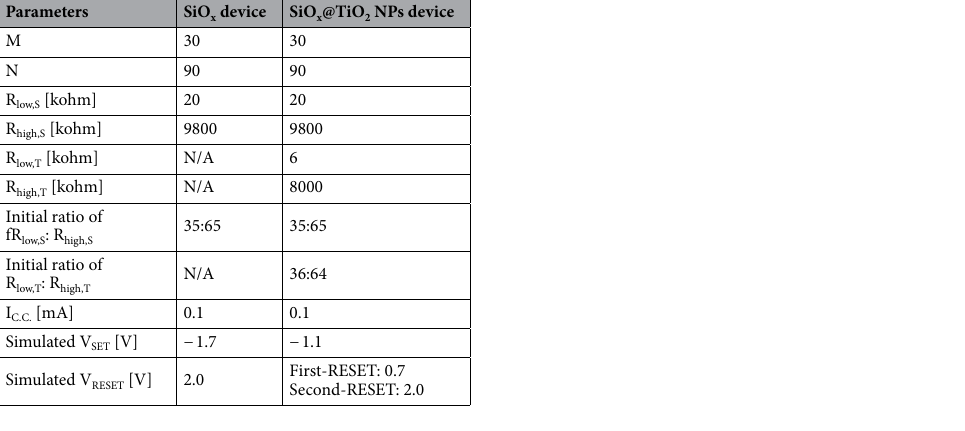
Table 1. The parameters for CB